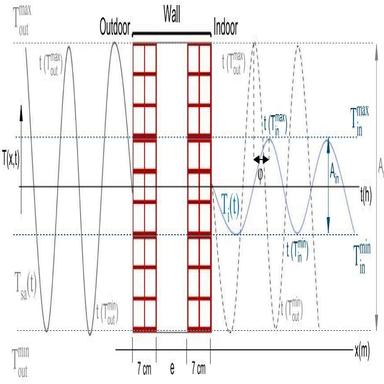
Schematic representation of the time lag (φ) and the decrement factor.